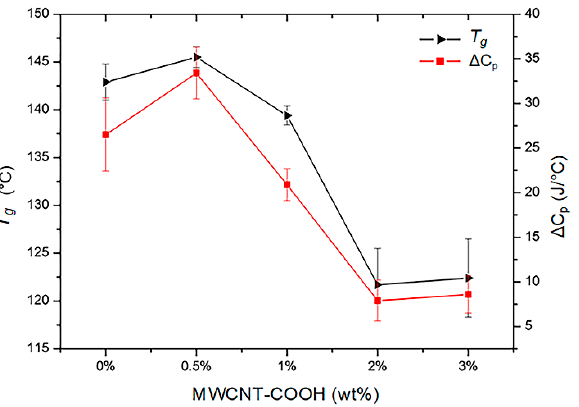
Figure 6. T g and ∆ C p trends of PNIPAM/MWCNT-COOH hydrogels as a function of filler concentration.